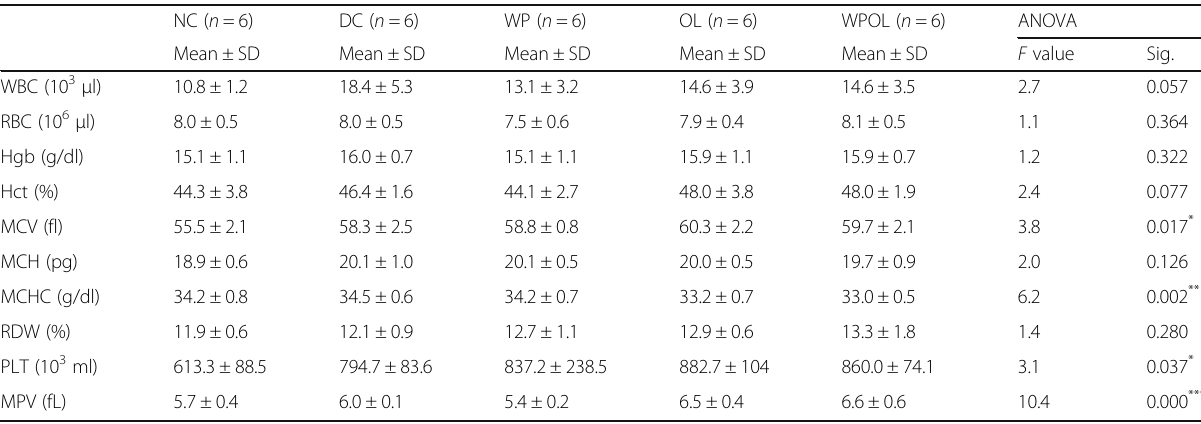
Table 1 Mean ± SD of hematological parameters of diabetic rats fed on whey protein, olive leaves extracts and their mixture NC ( n = 6) DC ( n = 6)